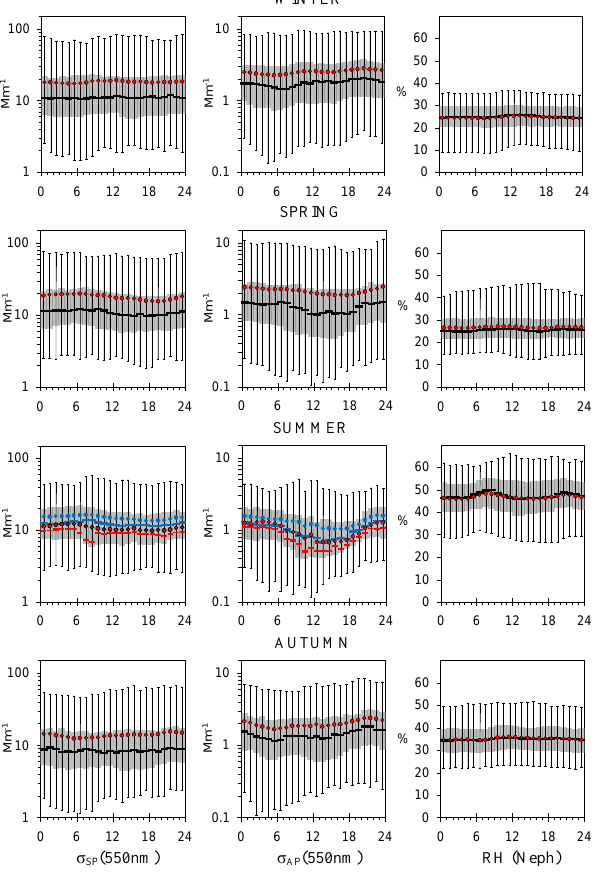
Fig. 6. Diurnal cycle of scattering coefficient ( σ SP ) , absorption co- efficient ( σ AP ) , and relative humidity measured in the nephelome- ter sample volume (RH Neph ) in four seasons in 13 October 2006– 31 May 2009. Red dot: average; black line: median; grey bar: 25th to 75thpercentiles; thin error bar: 2.5th to 97.5thpercentiles. For the summer σ SP and σ AP data the red symbols represent the mean and median of those data where RH NEPH < 50% and the respective blue symbols all data without RH filtering. For RH NEPH all data were used for the statistics. In other seasons all data were used.